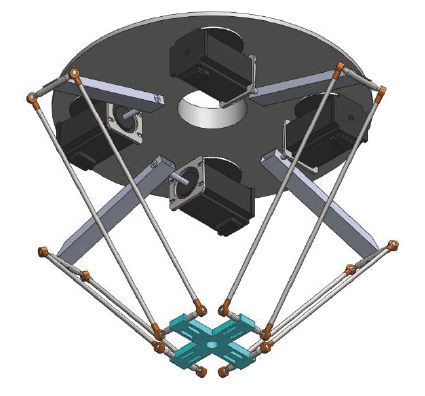
Figure 1: Solid work drawing of Delta/Par4-like parallel manipula- tor.